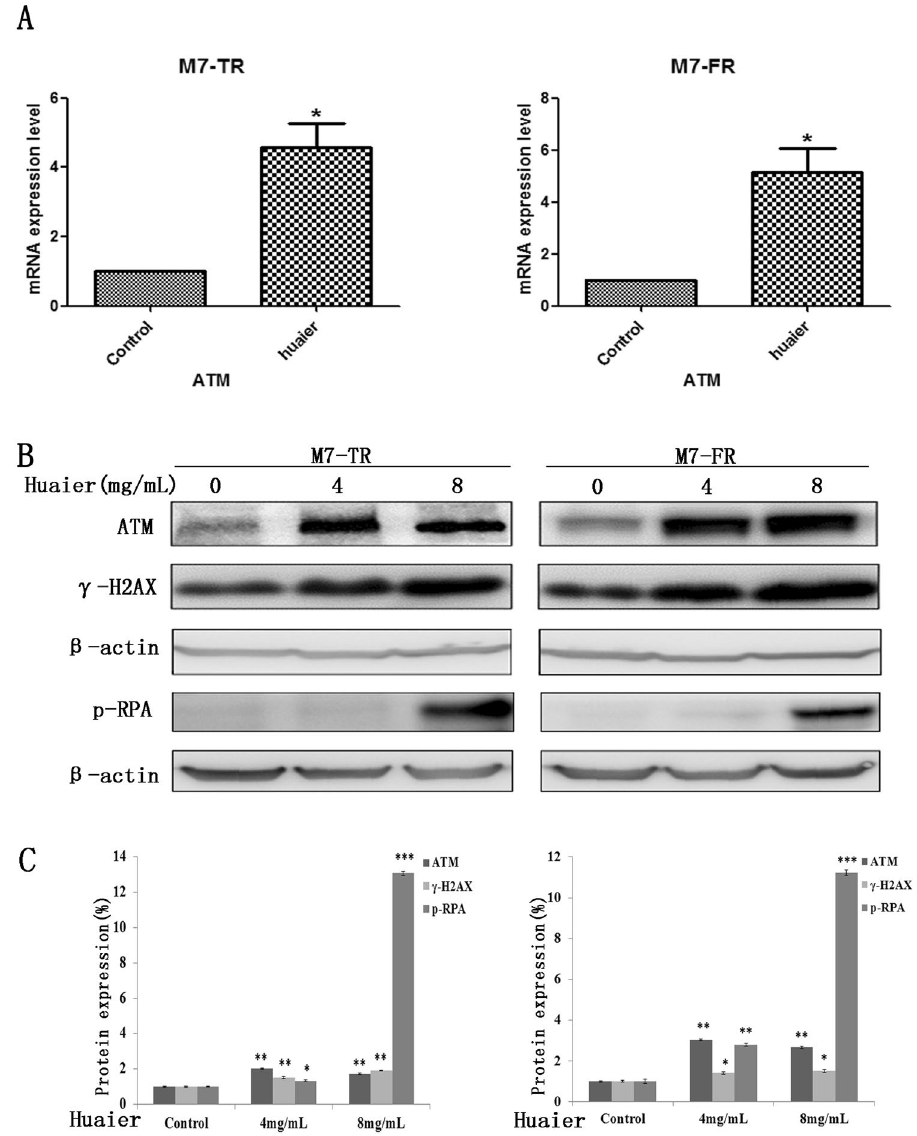
Figure 3. Changes in ATM, γ -H2AX and p-RPA in M7-TR and M7-FR cells after treatment with Huaier extract for 48 h. ( A ) M7-TR and M7-FR cells were treated with Huaier extract (8 mg/mL) for 48 h. The mRNA levels were detected by qRT-PCR. ( B and C ) Changes in protein levels in M7-TR and M7-FR cells after treatment with different concentration of Huaier extract for 48 h. * P < 0.05 or ** P < 0.01, compared with the controls. The data are presented as the mean ± SD of three separate